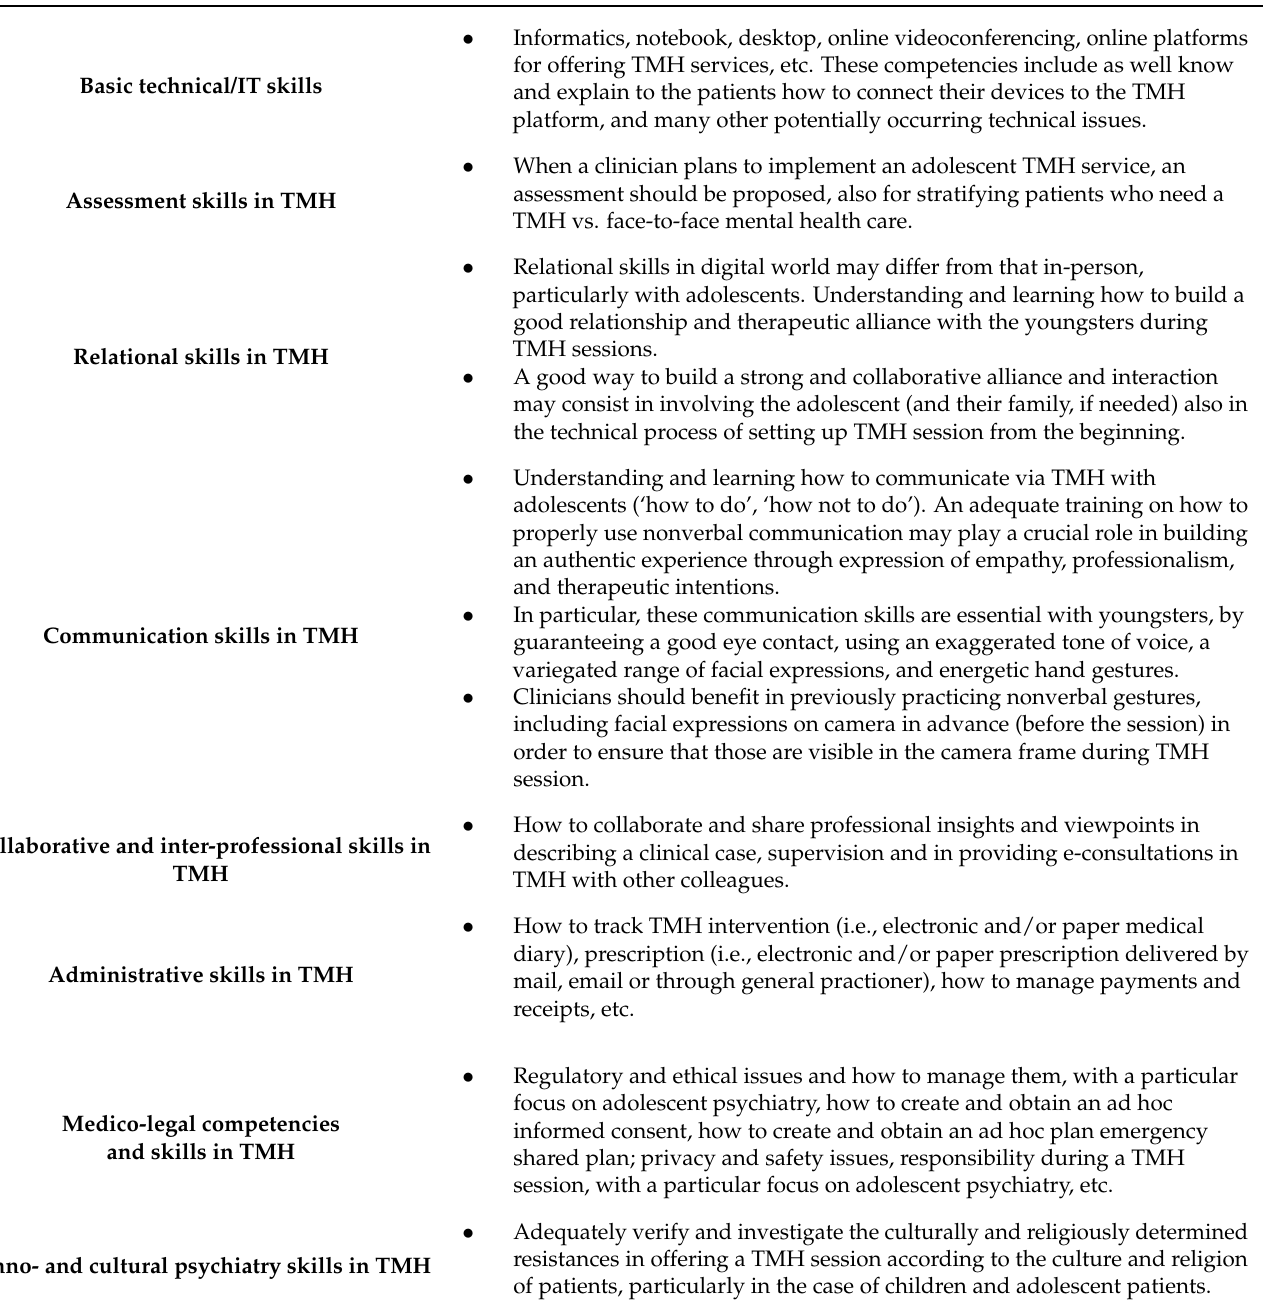
Table 3. Core competencies and skills in TMH by Adolescent Mental Health